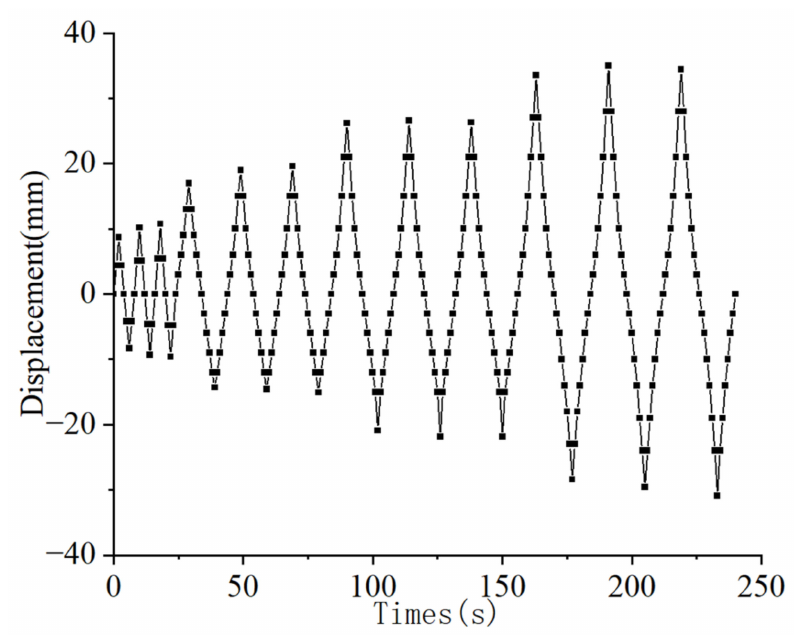
Figure 3. Cyclic horizontal displacement loading